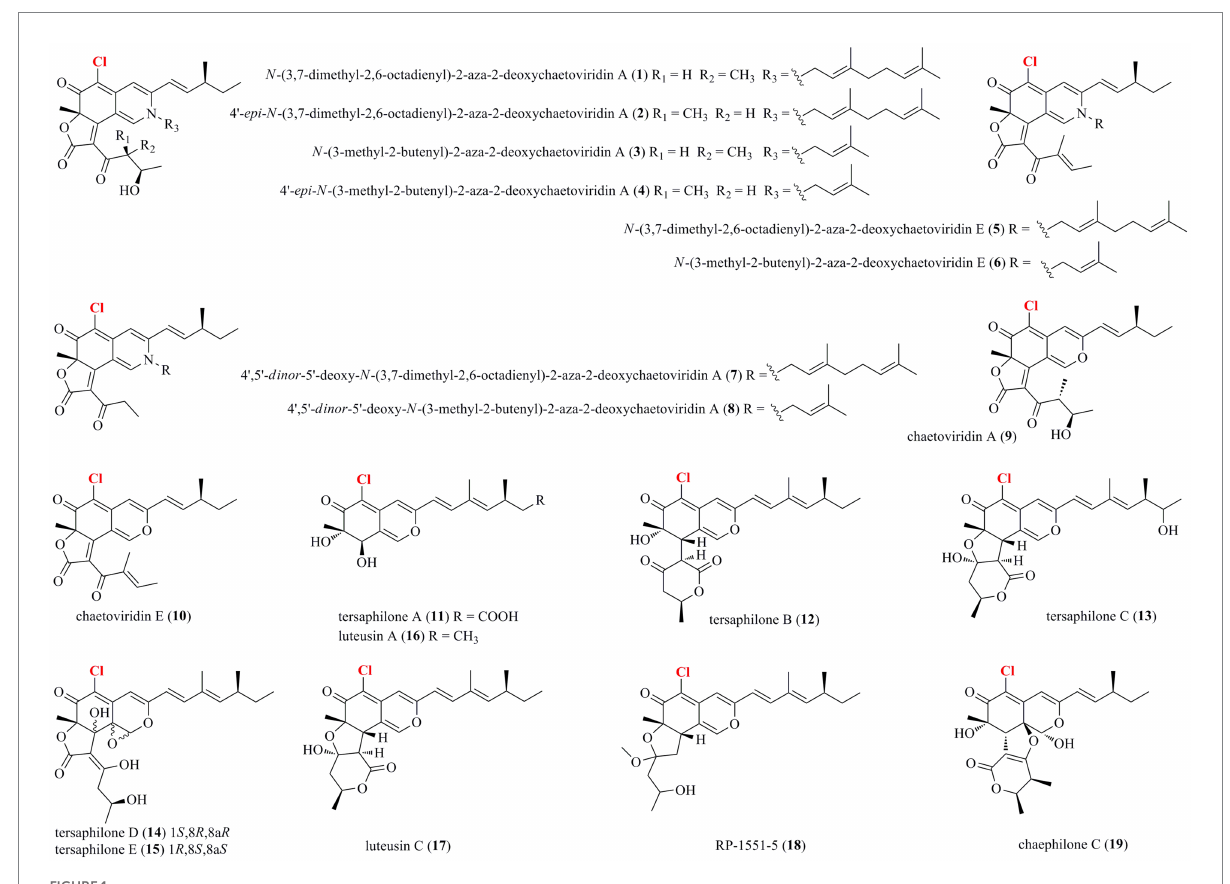
FIGURE 1 Halogenated azaphilones from marine-derived fungi ( 1–19